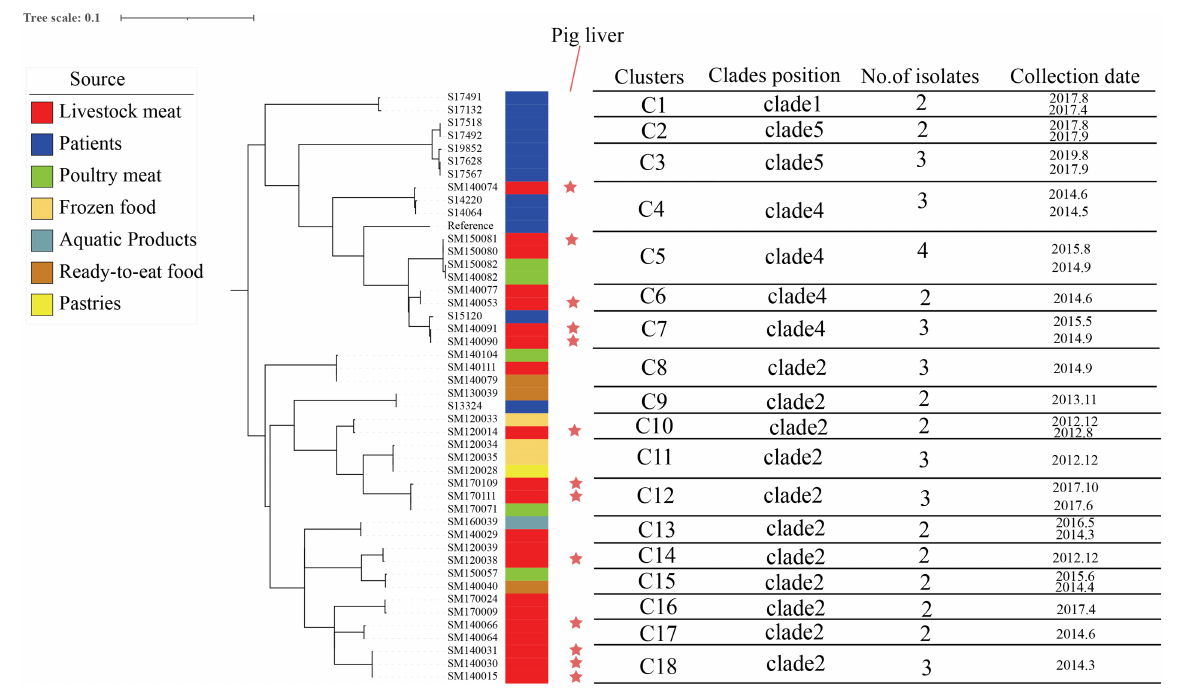
FIGURE 4 Maximum likelihood phylogenetic tree and strain information for 18 clonal clusters. The maximum likelihood tree of 18 clonal clusters is shown on the left; the color of the strip reports the origin of the strain: patients (blue), livestock meat (red), poultry meat (green), frozen food (earthy yellow), pastries (bright yellow), ready-to-eat food (brown), and aquatic products (lake blue); the red stars indicate that the strains were isolated from pig liver; and the contents of the line table contain the clades position, no. of isolates, and collection